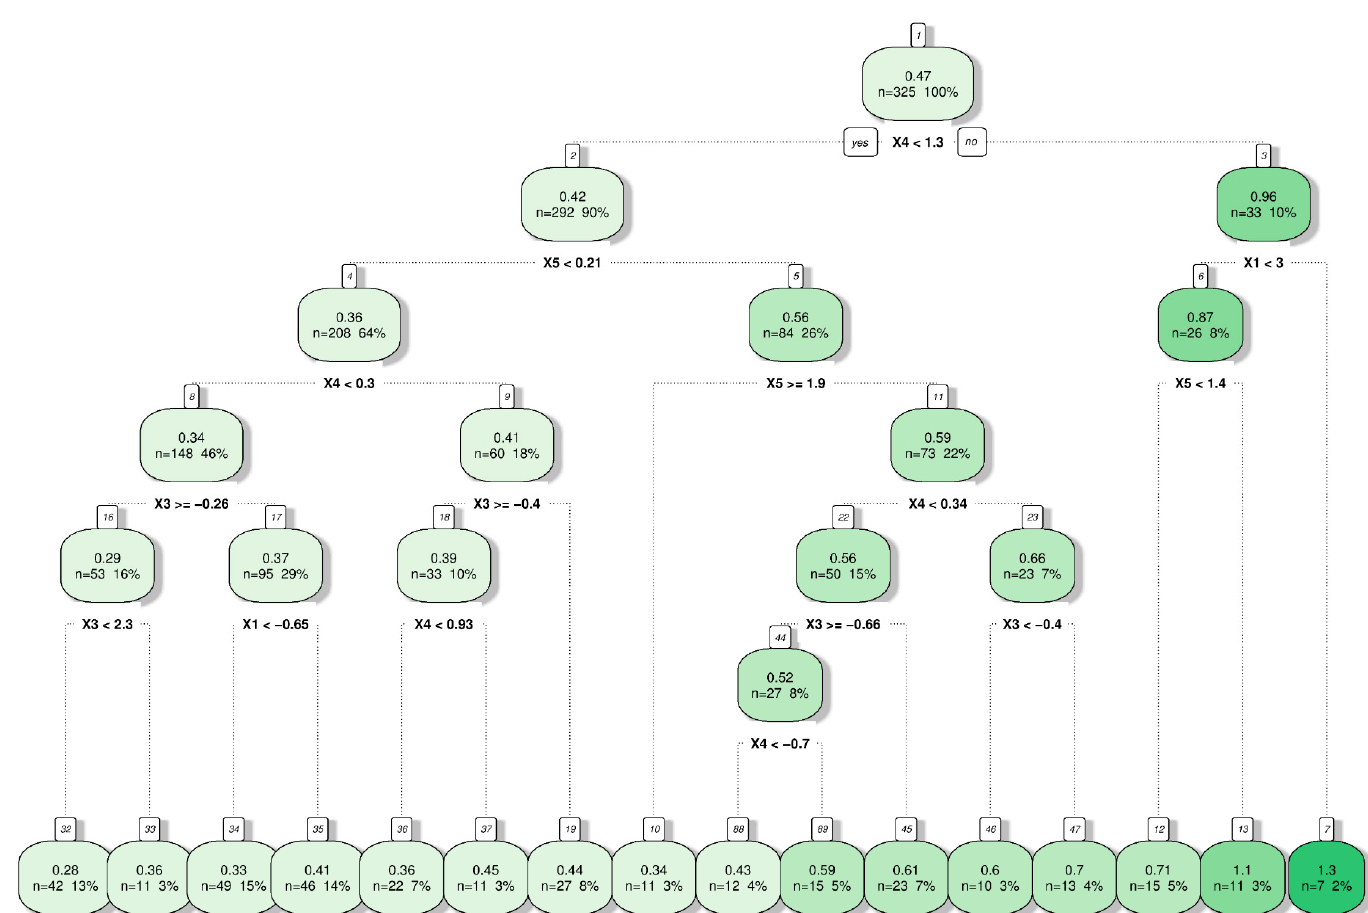
Figure 8. The structure of the classification and regression tree (CART) model for estimating ilmenite content.